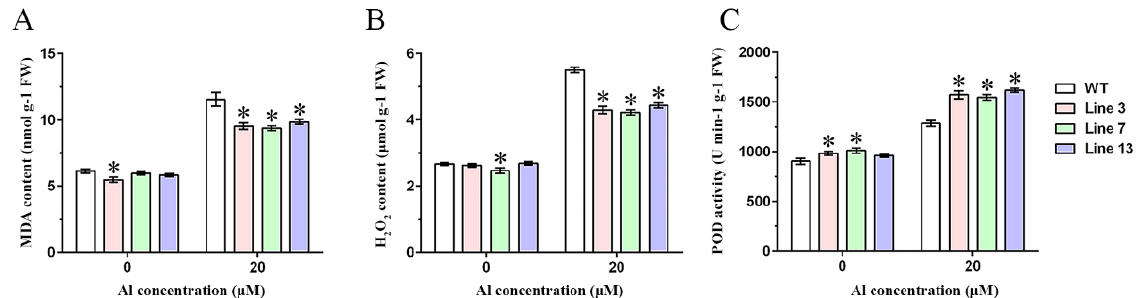
Figure 5. Determination of long-term hydroponic physiological parameters. Malonaldehyde (MDA) content ( A ), H 2 O 2 content ( B ) and peroxidase (POD) activity ( C ) in roots of WT and transgenic lines treated with 0 and 20 μ M AlCl 3 for 10 d. WT: wild type (Guixia1, Al-sensitive). Line 3, Line 7 and Line 13: GmWRKY81 transgenic lines. Asterisks denote significant differences: p < 0.05. The data are presented as the means ± SD from three biological replicates, and each biological replicate included 4